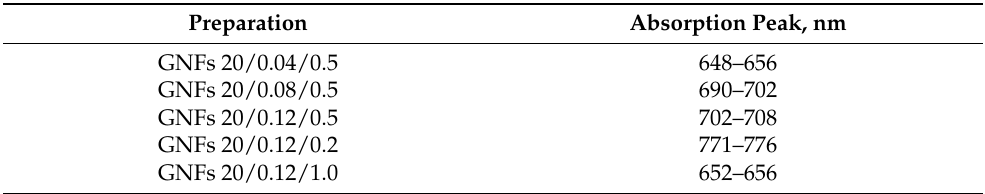
Table 2. Spectral characterization of the obtained